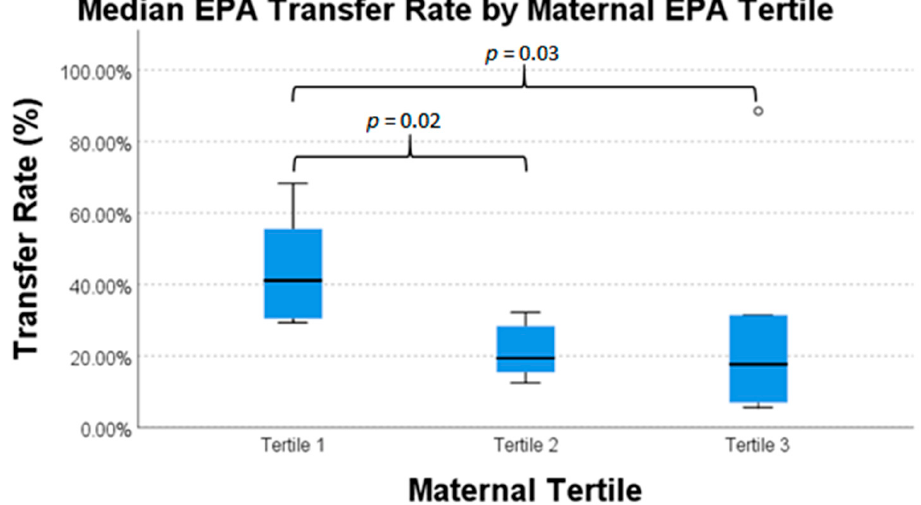
Figure 2. Intrauterine transfer percentage of eicosapentaenoic acid (EPA) across tertiles of maternal plasma